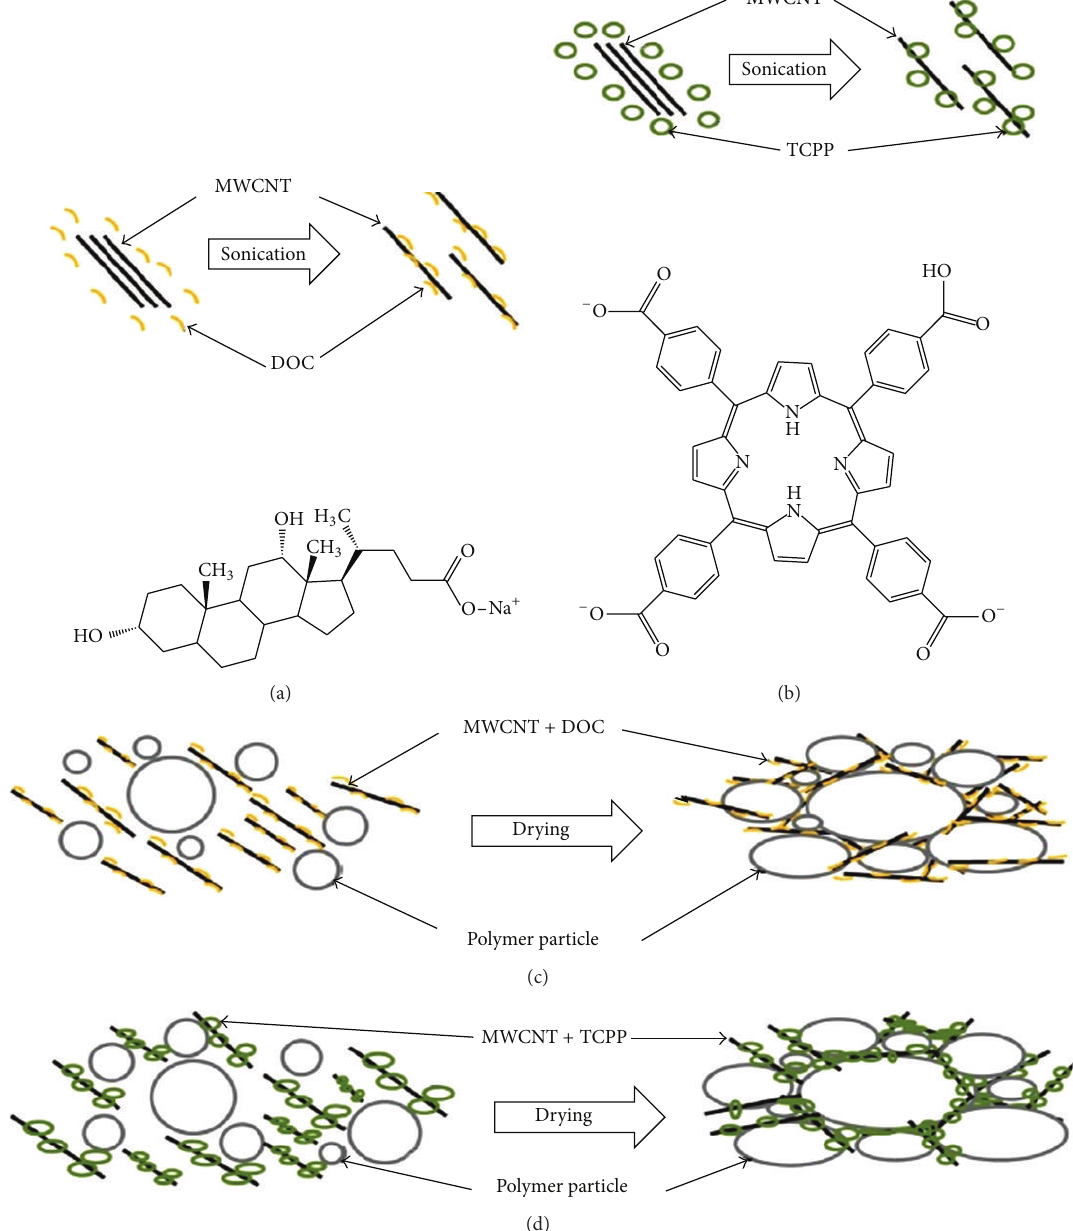
Figure 9: (a) and (b) show schematic diagram of carbon nanotubes dispersed in two different stabilizing agents, and (c) and (d) show the formation of network after water is dried out [81] where MWCNT: multi-walled carbon nanotube, TCPP: mesotetra(4-carboxyphenyl) porphine and DOC: sodium